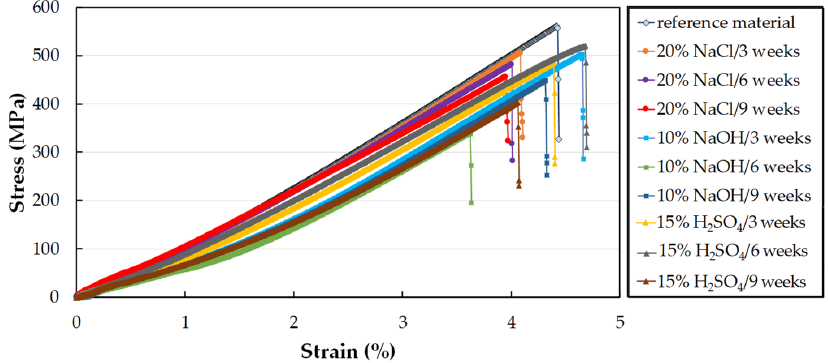
Figure 7. Influence of the time of exposure to 20% NaCl, 10% NaOH, and 15% H 2 SO 4 at 60 °C on tensile stress ‐ strain curves of the CFRP composite.